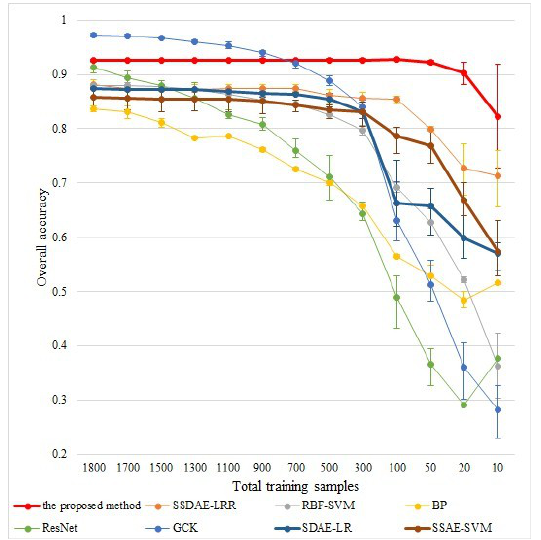
Figure 13. OA curves for different methods in the classification of the Indian Pines dataset with different numbers of labelled